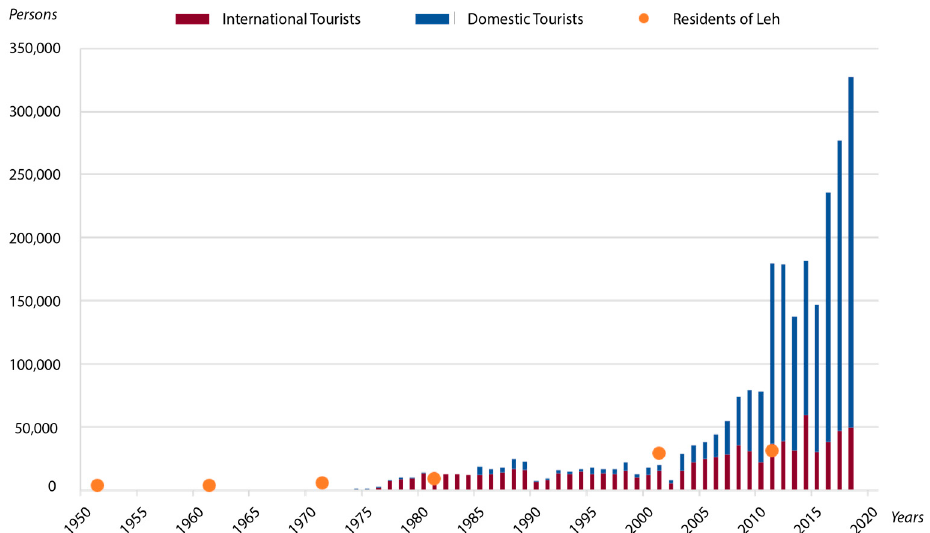
Figure 3. Tourist arrivals to Ladakh and population development in Leh (data: Census of India 2011 and Tourism Department, Leh 2019).